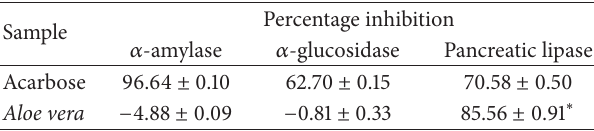
Table 1: Percentage inhibition of AVG against key